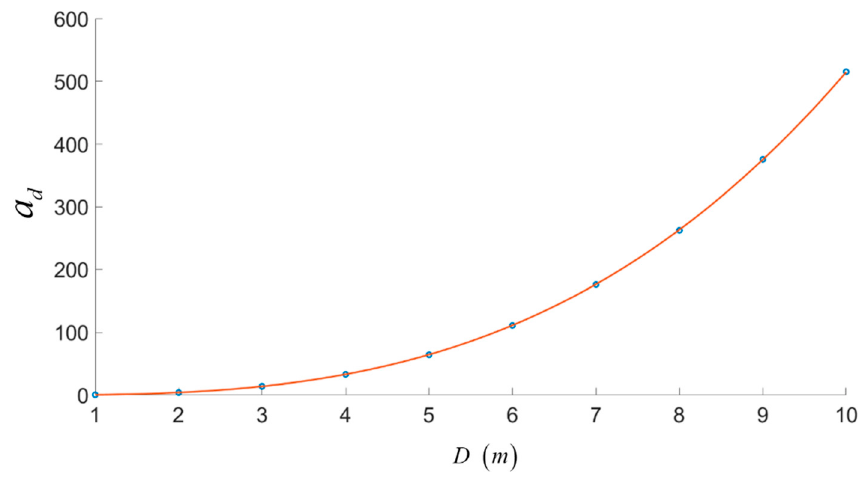
Figure 11. The relationship between D and p .